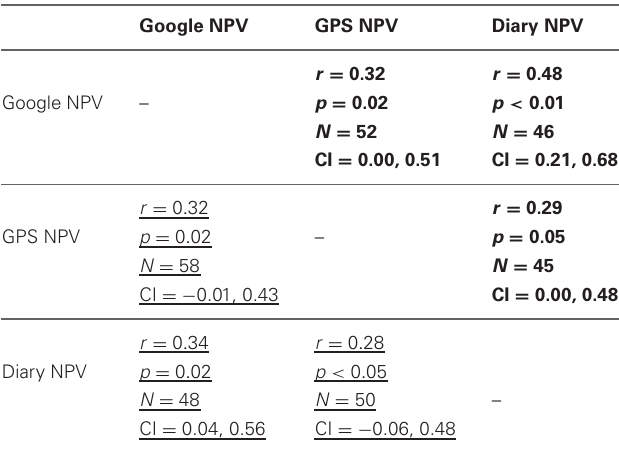
Table 4 | Correlations among NPV weekend and weekday variables.